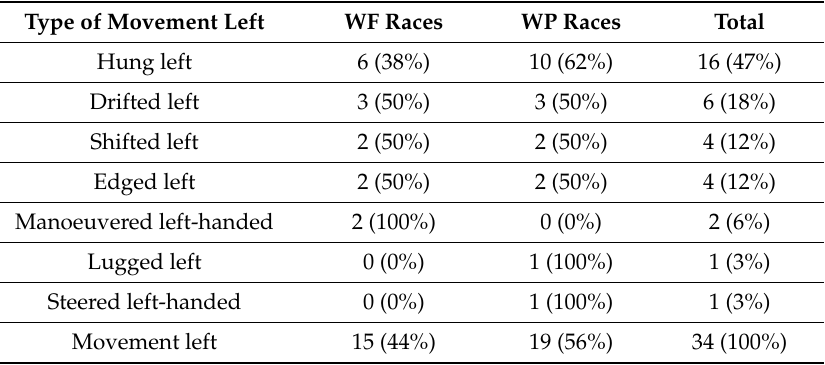
Table 1. The 34 instances of horses moving to the left, as described in the stewards’ reports (excluding the one instance of a horse moving both ways).